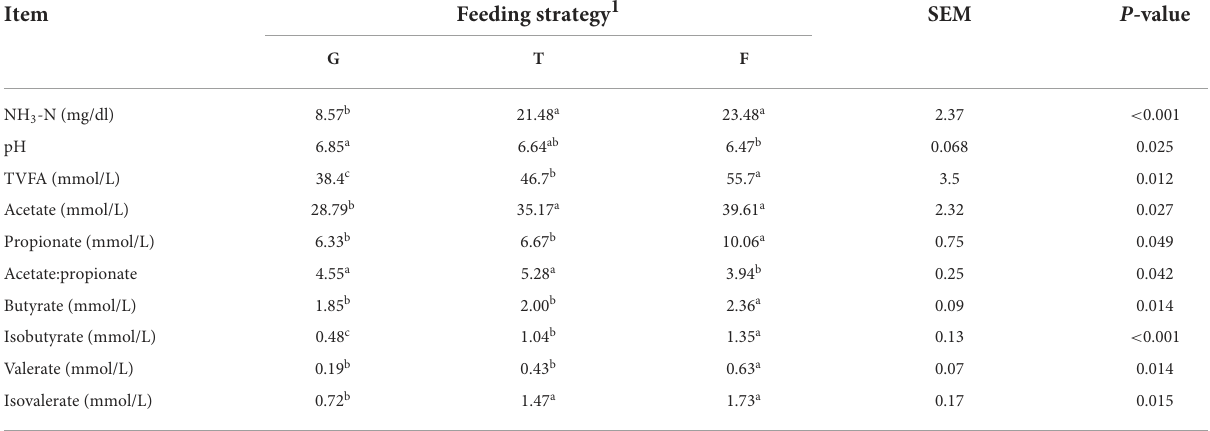
TABLE 3 Effects of different feeding strategies on ruminal fermentation in Gangba sheep.